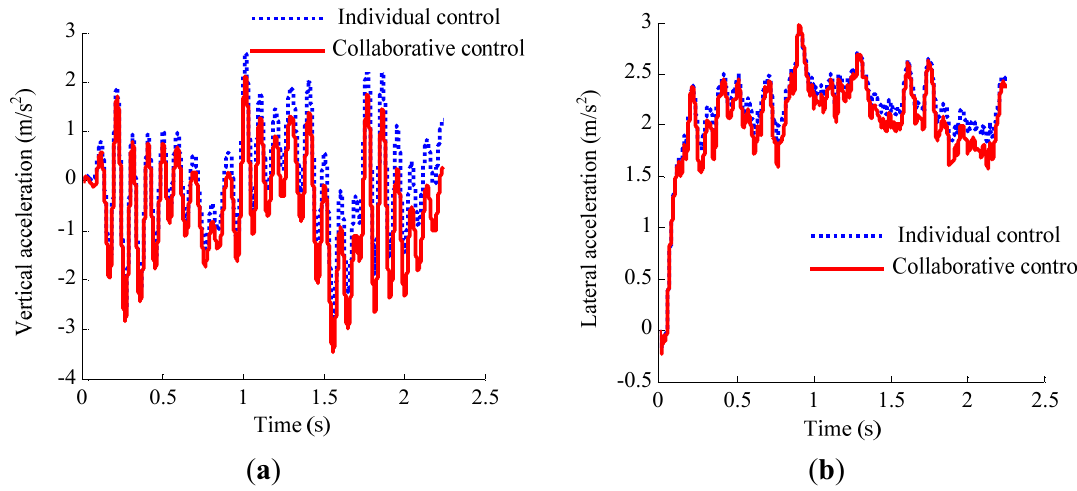
Figure 10. Simulation results of vehicle vertical acceleration and lateral acceleration: